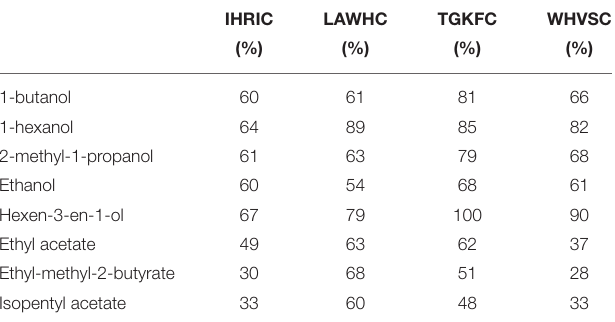
TABLE 2 | Percentage of the binding score, representing the affinity of the peptides toward the volatile compounds used in experimental